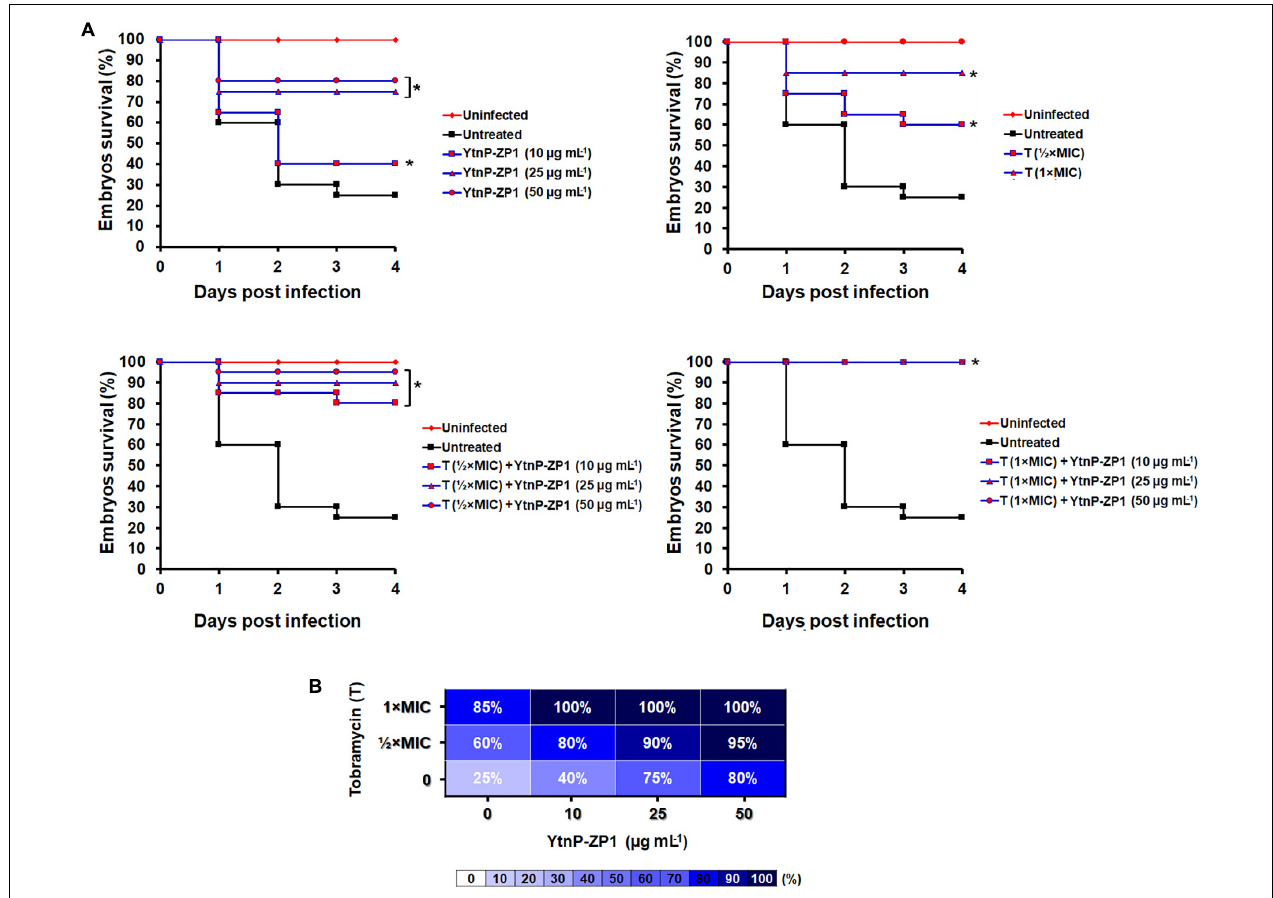
FIGURE 8 | YtnP-ZP1 efficiently rescued the zebrafish embryos of the lethal P. aeruginosa PAO1-GFP-infection. Wild-type zebrafish embryos were infected with P. aeruginosa PAO1-GFP in the circulation valley and incubated at 32 ◦ C ( n = 20 per dose). The Kaplan–Meier survival curves (A) and the survival heat map at 120 hpf (B) of P. aeruginosa PAO1-infected embryos upon the different treatments are shown. ∗ P < 0.05.